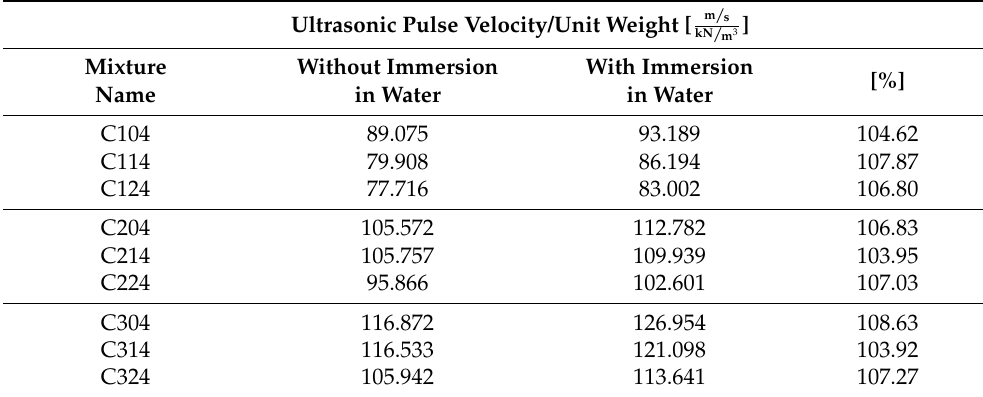
Table 7. Effect of water on ultrasonic pulse velocities, normalized by the unit weight.